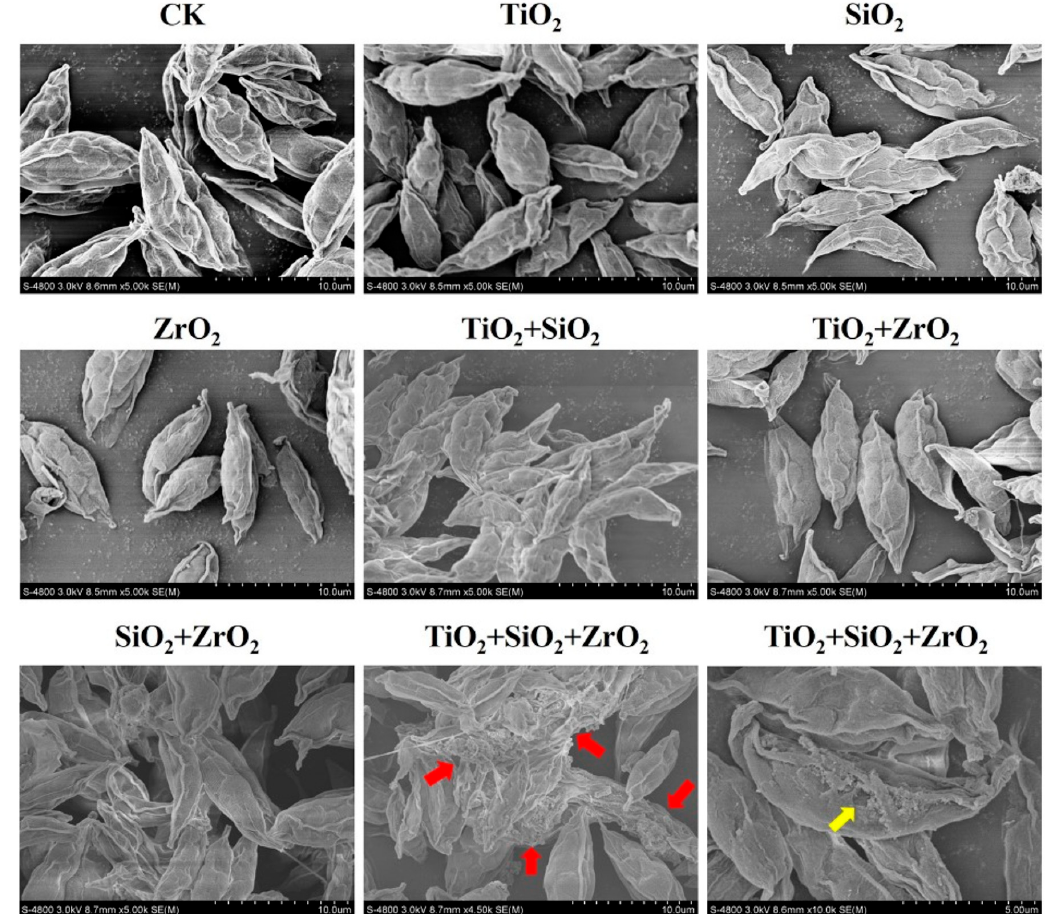
Figure 6. Superficial structures of S. obliquus exposed to 1 mg/L of NPs alone, 1 mg/L of single NPs in binary combination and 1 mg/L of single NPs in ternary combination. CK represents control. The red arrow and the yellow arrow indicate cell-cell adhesion and cell defect, respectively.